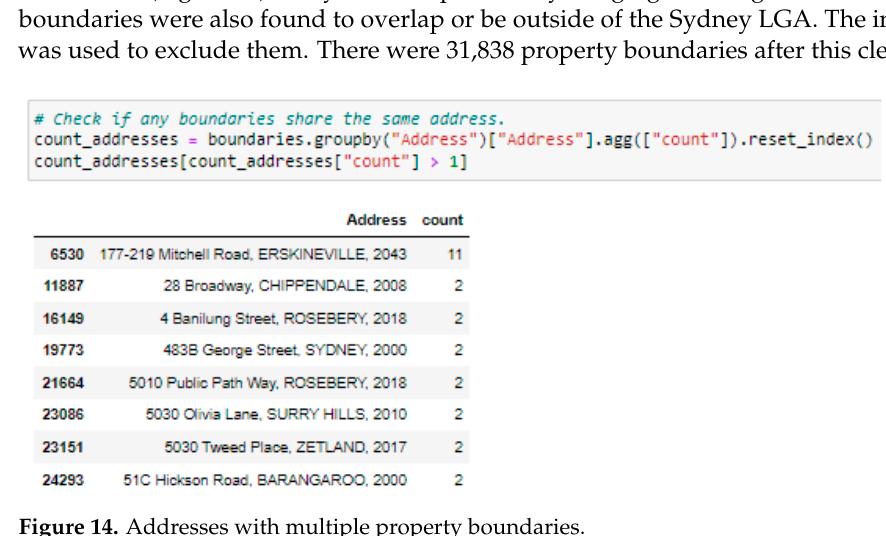
Figure 14. Addresses with multiple property